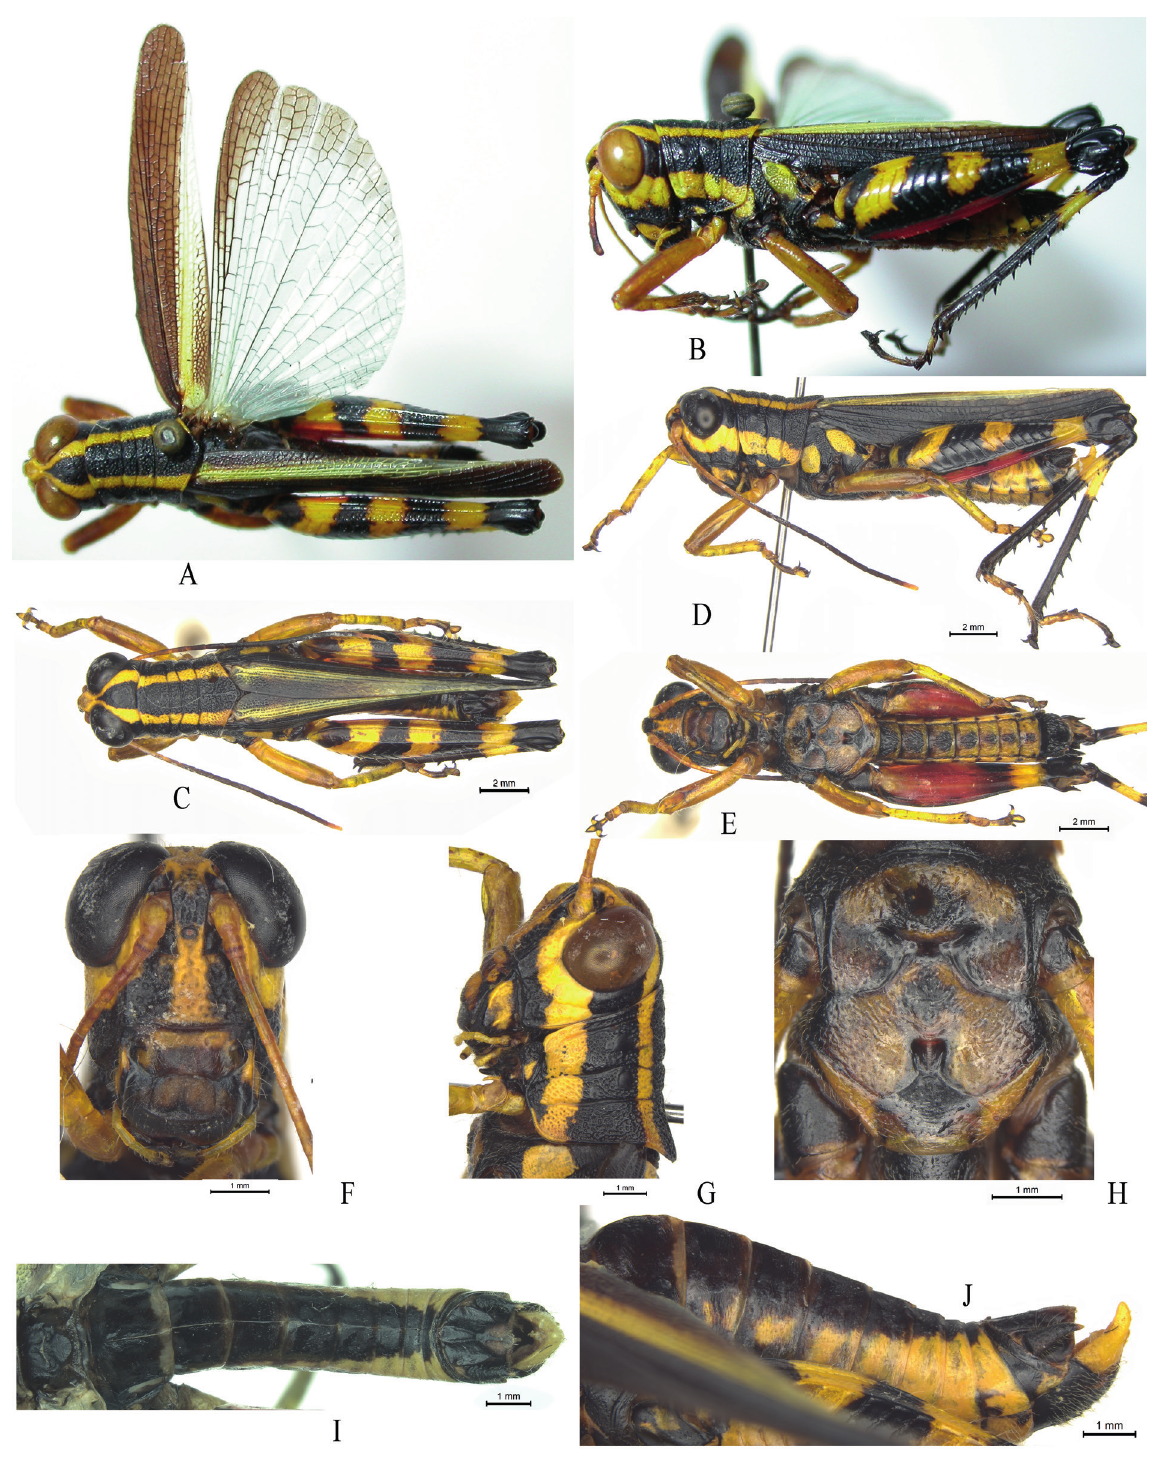
Fig. 3. Bannacris punctonotus Zheng, 1980 syn. nov. (= Pseudotraulia cornuata Laosinchai & Jago, 1980). A–B . ♂ (SNU) from Yunnan, Jinghong, Jinuo, habitus in dorsal and lateral views. C–J . ♂ (DU) from Yunnan, Jinghong, Yexianggu. C–E . Habitus of in dorsal, lateral and ventral views. F . Head in frontal view. G . Head and thorax in lateral view. H . Meso- and metasterna in ventral view. I–J . Abdomen in dorsal and lateral